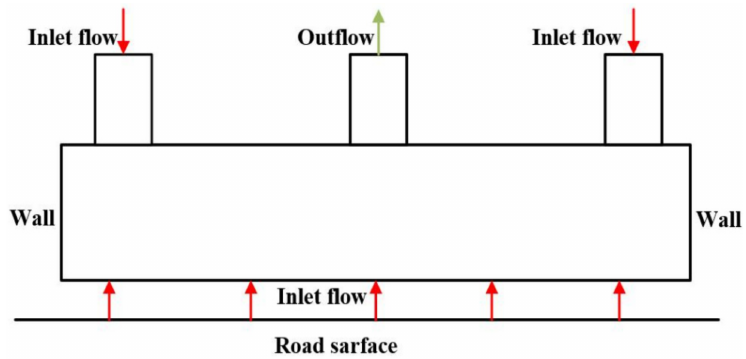
Figure 4. Boundary conditions applied to the gridding